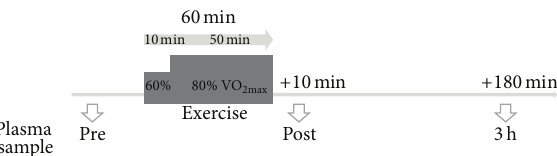
Figure 1: Experimental setup of the study